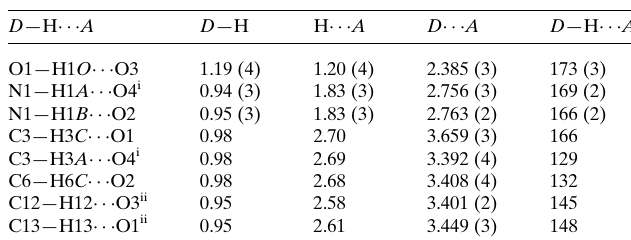
Table 1 Hydrogen-bond geometry (A˚ , (cid:5) ).